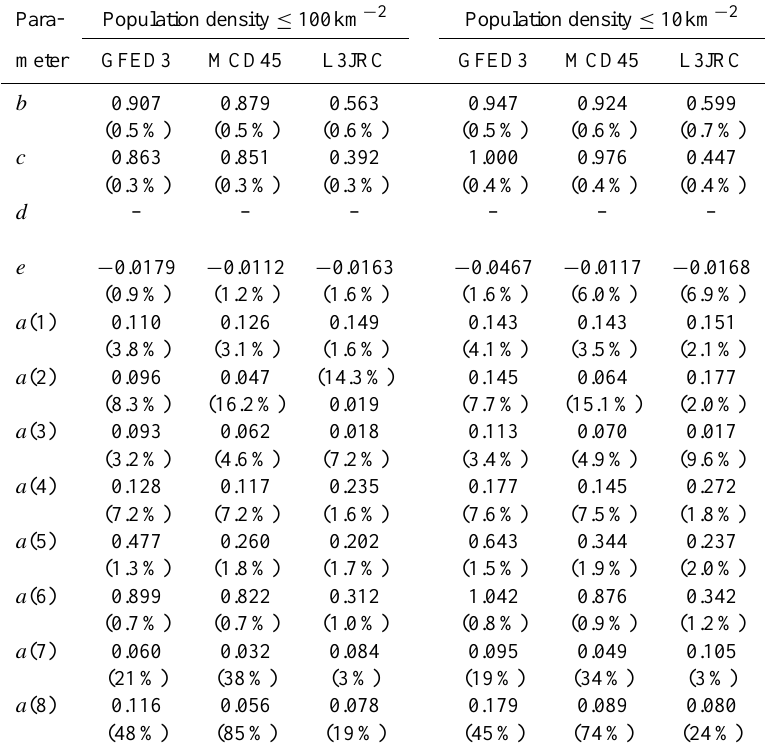
Table A1. Optimal parameters and uncertainties for further cases with eight regions ∗ . Relative uncertainties given in brackets.